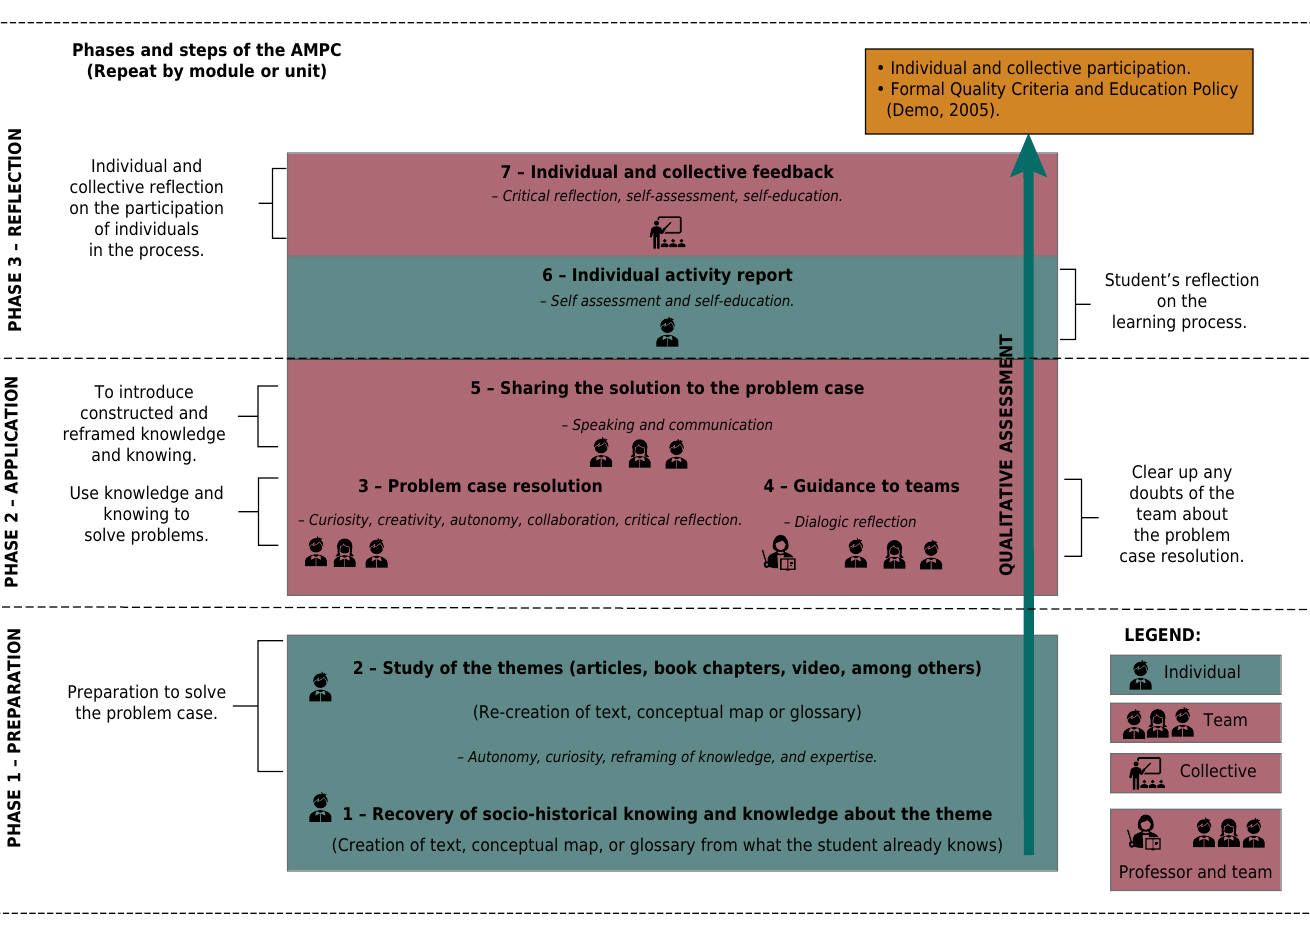
Figure 1. Structure of the Alternative Methodology of Problem Cases